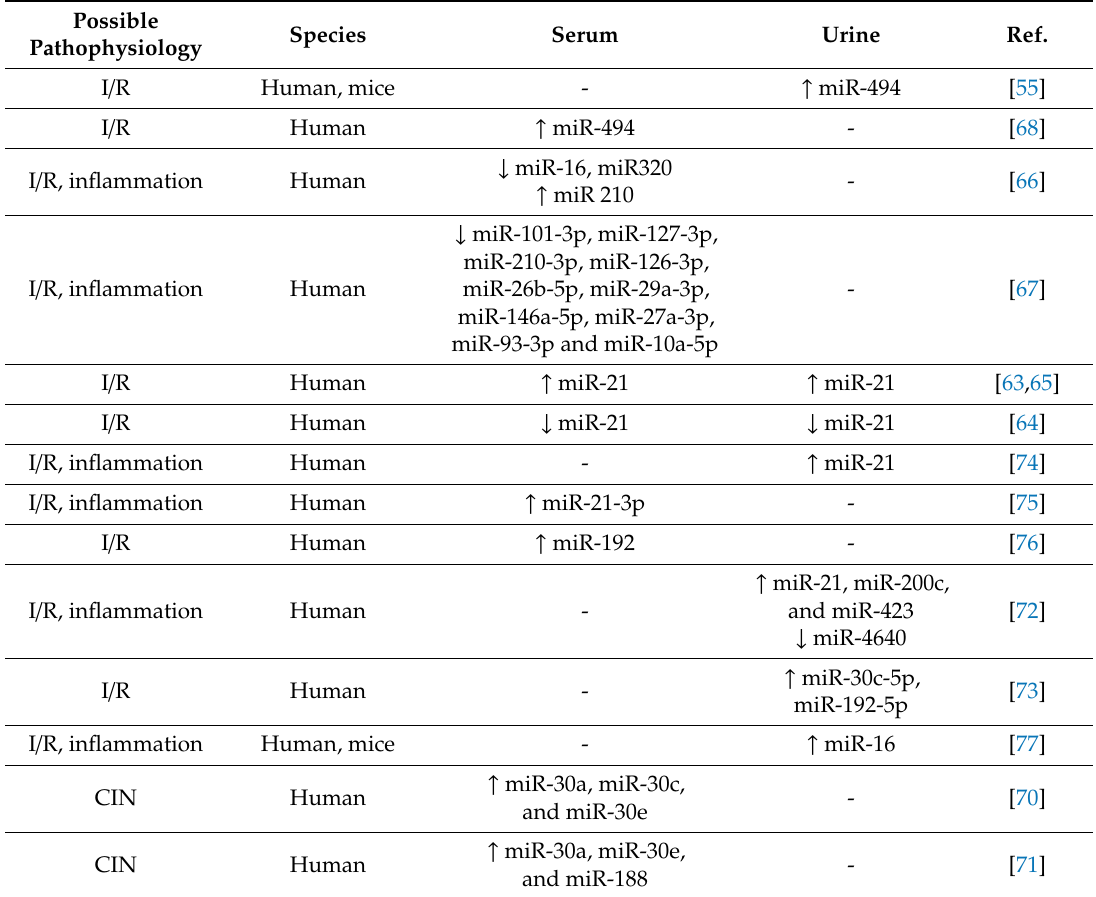
Table 1. MicroRNAs in acute kidney injury as novel